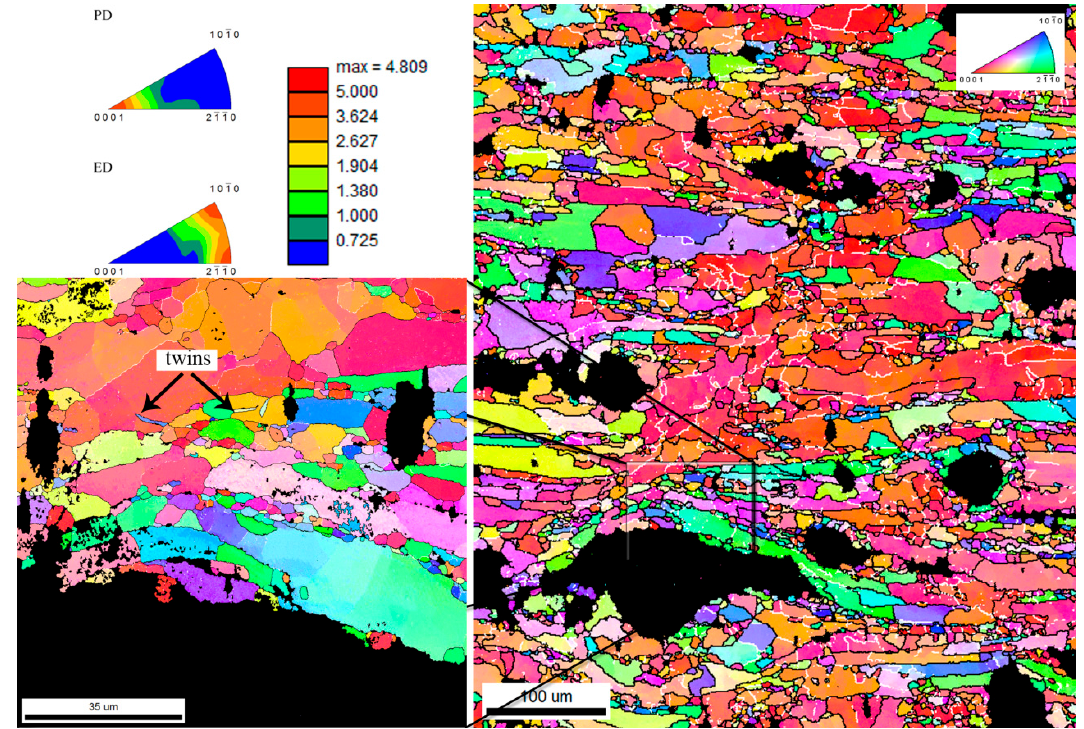
Figure 4. Inverse pole figures and IPF maps (PD) of Zn/HA8 with visible twins in the structure.